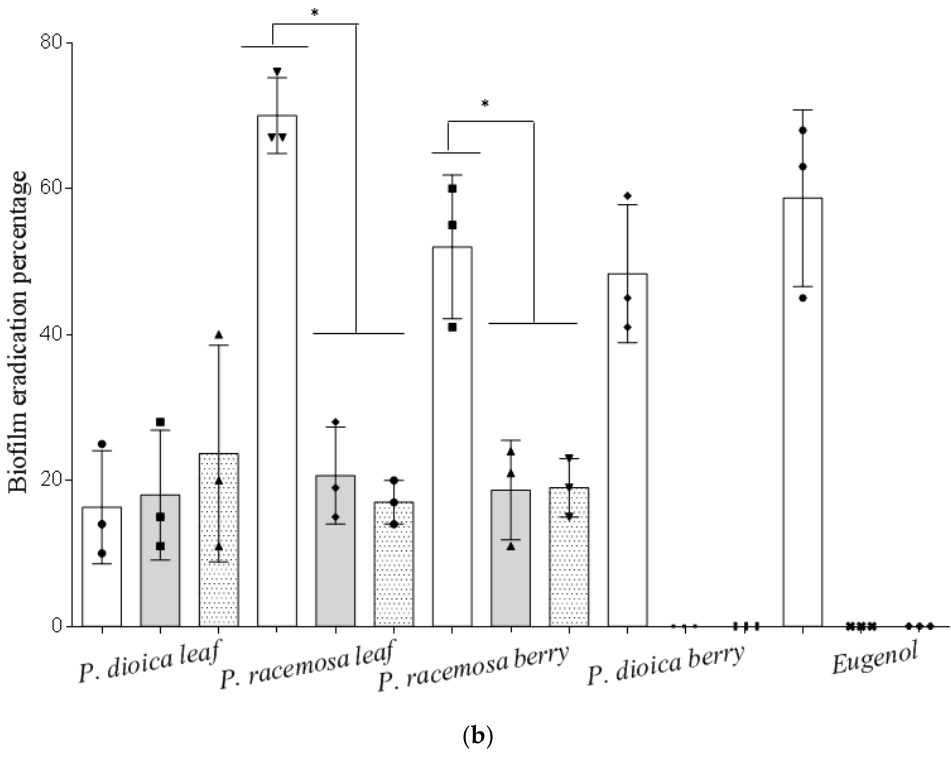
Figure 1. ( a ) Biofilm inhibition percentages of Pimenta essential oils/eugenol at a dose of 0.1× MIC against MDR AB-8 (white) and AB-16 (light shade) isolates. ( b ) Biofilm eradication percentages of the tested E.Os/eugenol at a dose of 0.1× MIC against MDR AB-8 (white), AB-R (gray), and AB-16 (light shade) isolates. The symbols in each column ( ● , ■ , ⯅ , ◆ , , × , ) represent each data point of the triplicate experiments performed for each E.O and eugenol against the tested bacterial isolates. Data represent the means of biofilm inhibition/eradication percentages ± SD, n = 3 (one-way ANOVA, followed by Tukey’s multiple comparisons, p -value < 0.0001). (*) Means statistically significant difference exists between columns.